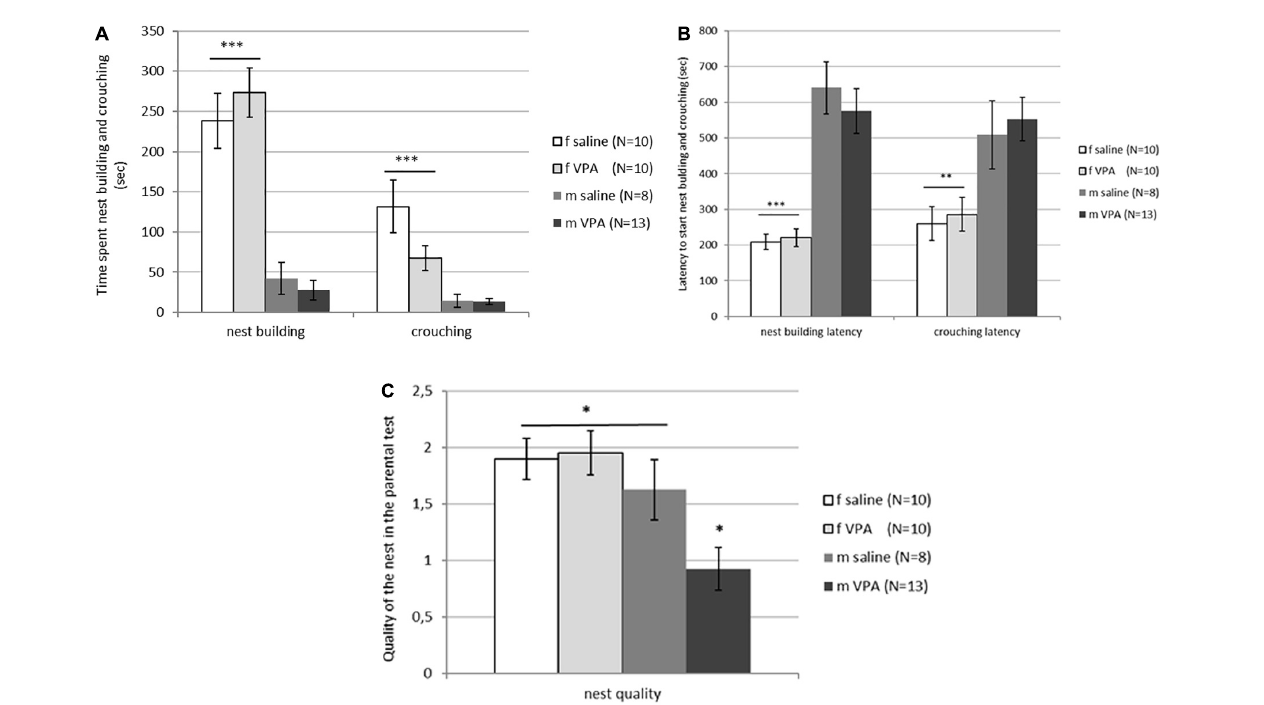
FIGURE4 (A) Parental behavior of control and valproate (VPA) mice in the first and second tests. Females spent significantly more time crouching over the pups ( p ∗∗∗ < 0.0001) and nest building ( p ∗∗∗ < 0.0001) compared to males regardless of the treatment. (B) Parental behavior of control and VPA mice in the first and second tests. Latency to start crouching ( p ∗∗ < 0.01) and nest building ( p ∗∗∗ < 0.0001) was significantly shorter in females compared to males of both treatments. (C) Nest quality of control and VPA mice in the first and second test. VPA males possessed a significantly poorer nest than saline males and females of both treatments ( p ∗ < 0.05).